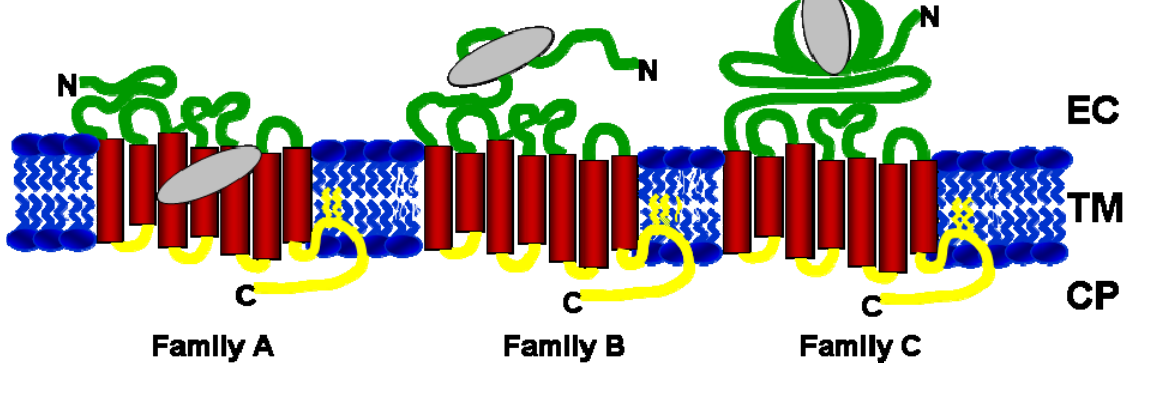
Figure 1. Schematic diagram of representative structural organizations of GPCRs highlighting the most common endogenous ligand binding site locations for each of the major GPCR family members. Extracellular and cytoplasmic loops are colored in green and yellow, respectively. Transmembrane helices are colored in red and represented as cylinders. The membrane bilayer is shown in blue color. The endogenous (orthosteric) ligand binding site in each family is represented by an ellipse colored in